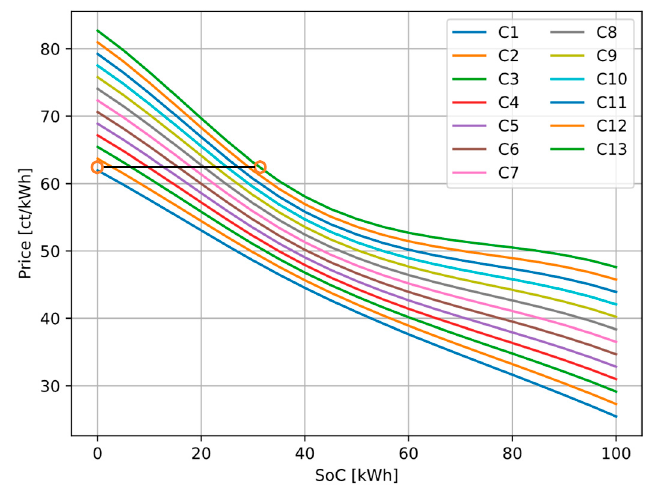
Figure 4. 13 Trajectories of each demand function depending on the State of charge—drawn from the survey. The trajectories show different exemplary price sensitivity behavior.